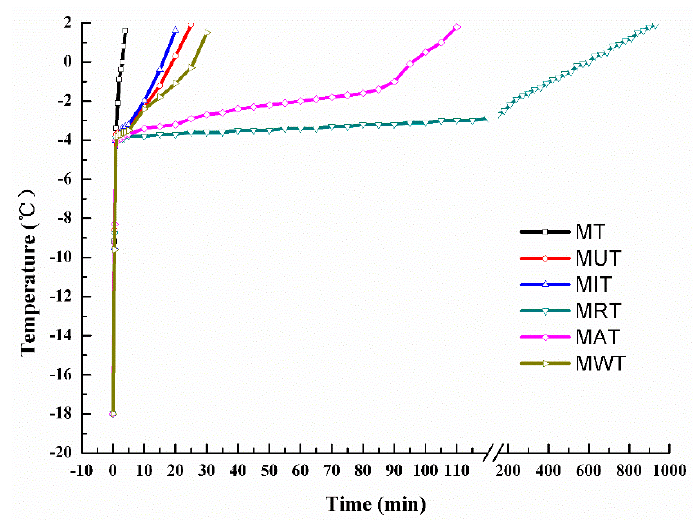
Figure 2. Temperature changes in frozen pork samples under six di ff erent thawing conditions. MT: Microwave thawing (100 W); MUT: Microwave combined with ultrasonic thawing; MIT: Microwave combined with 35 ◦ C water immersion thawing; MRT: Microwave combined with 4 ◦ C refrigeration thawing; MAT: Microwave combined with air convection thawing; MWT: Microwave combined with running water thawing.